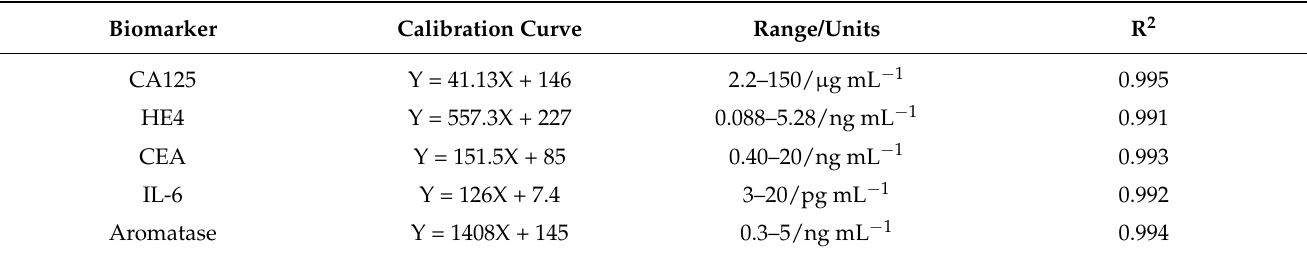
Table 1. Calibration curves and concentration ranges for particular biosensors included in the multiple-array biosensor.